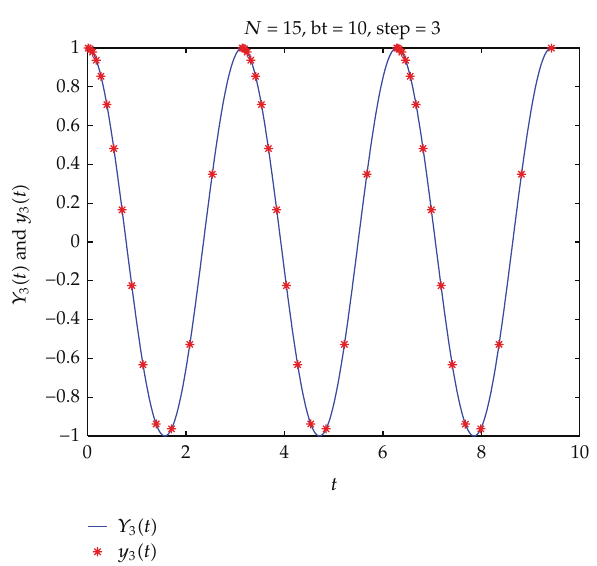
Figure 6: Numerical solution of refined method and exact